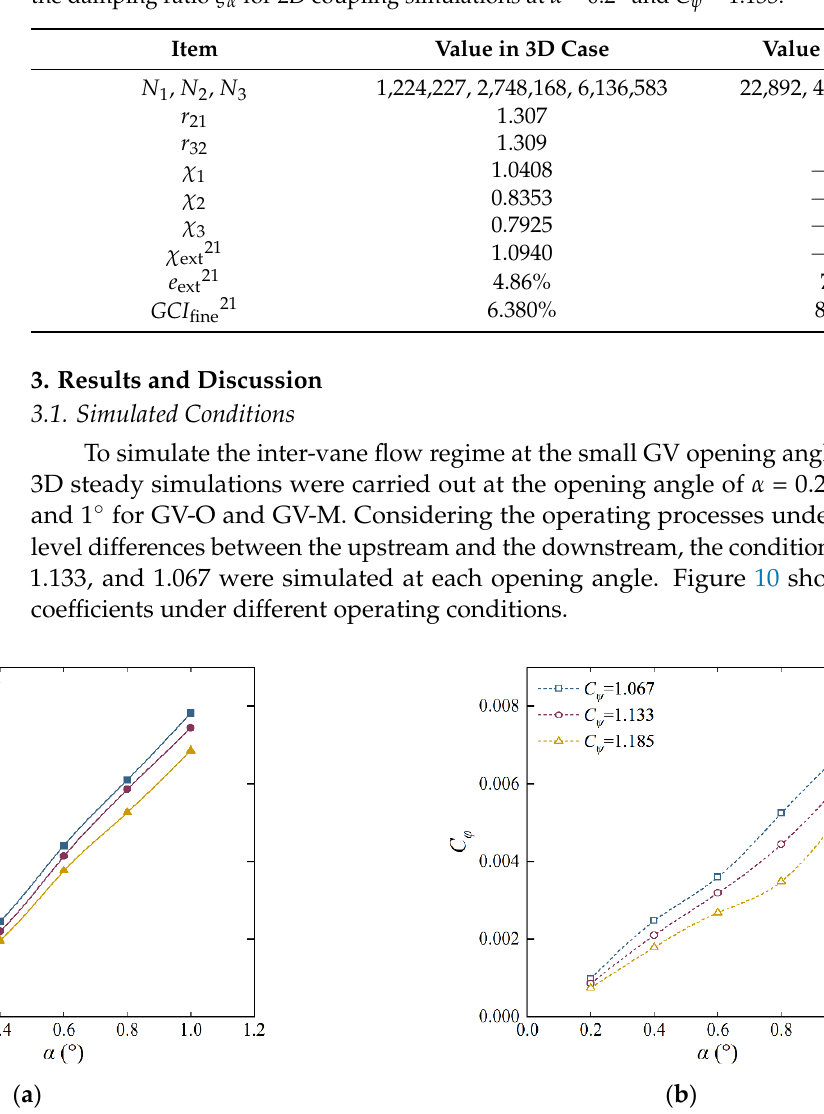
( b ) Figure 11. Pressure difference coefficient between the inlet and outlet of GV with respect to GV opening angle under conditions of different head coefficients. ( a ) GV-O; ( b ) GV-M. 𝛿𝜓 = 𝑝 t1 − 𝑝 s2 0.5𝜌𝜔 2 𝑅 𝑟𝑒𝑓2 (10) 3.2. Inter-Vane Flow at Different Opening Angles Figures 12 and 13 show the flow field on the mid-section plane in the double-stage radial vane at different opening angles under the example condition of C ψ = 1.133. The static pressure coefficient C p and the velocity coefficient C v can be expressed as follows: